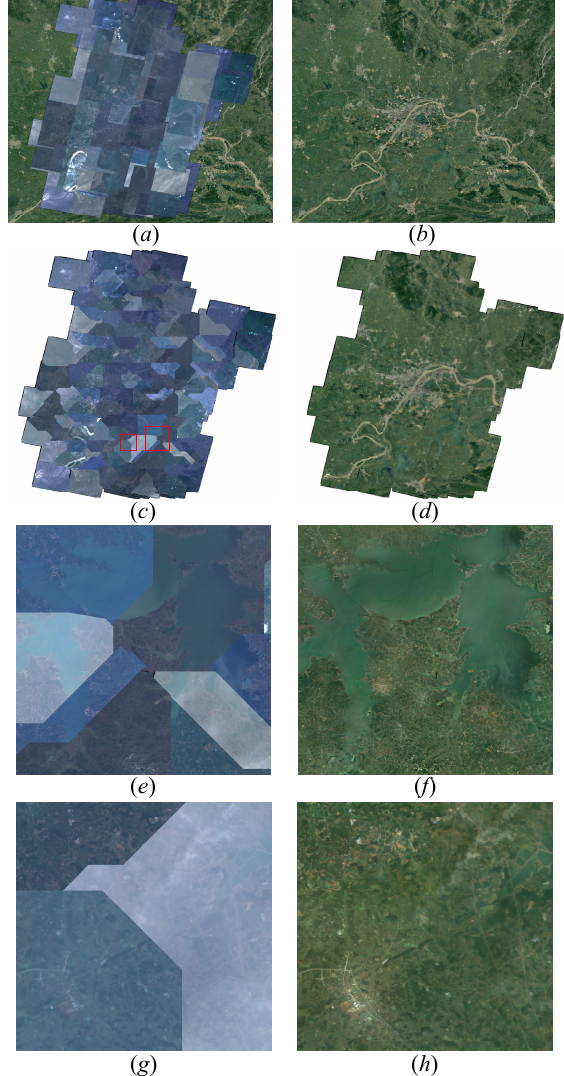
Figure 5. Color correction results of Experiment 1. ( a ) is overlay schematic of input images and the reference image, ( b ) is the external reference image, ( c-h ) is the images before and after color